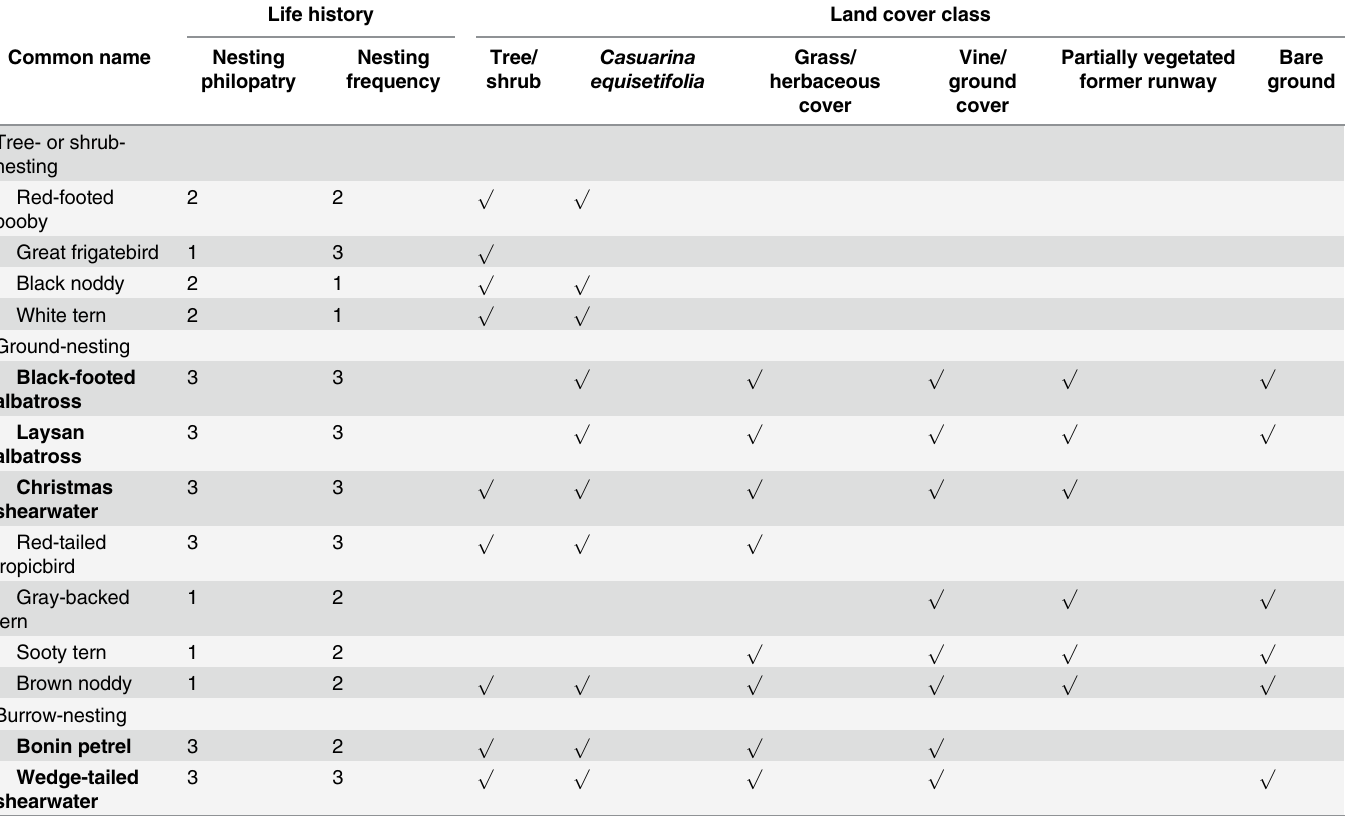
Table 2. Types of nesting habitat used by seabirds and rankings of species ’ sensitivity to storm-wave overwash at Midway Atoll. Seabird behavior and nesting habitat by land cover class identified from satellite imagery at Midway Atoll (2011). Species ’ sensitivity to population-level effects of storm-wave overwash were ranked from least (1) to most (3) sensitive. Nesting philopatry (natal and nest site fidelity) of species were ranked relatively as low (1), moder- ate (2), or high (3) and nesting frequency as annual – semi-annual (1), annual (2), annual – alternate (3; see [28] for additional details). Land cover classes beach, wetland, and infrastructure are not used as seabird nesting habitat at Midway Atoll (see [23]). Species in bold lay at most a single egg per year. Spe- cies with populations less than 100 nesting pairs at Midway Atoll were